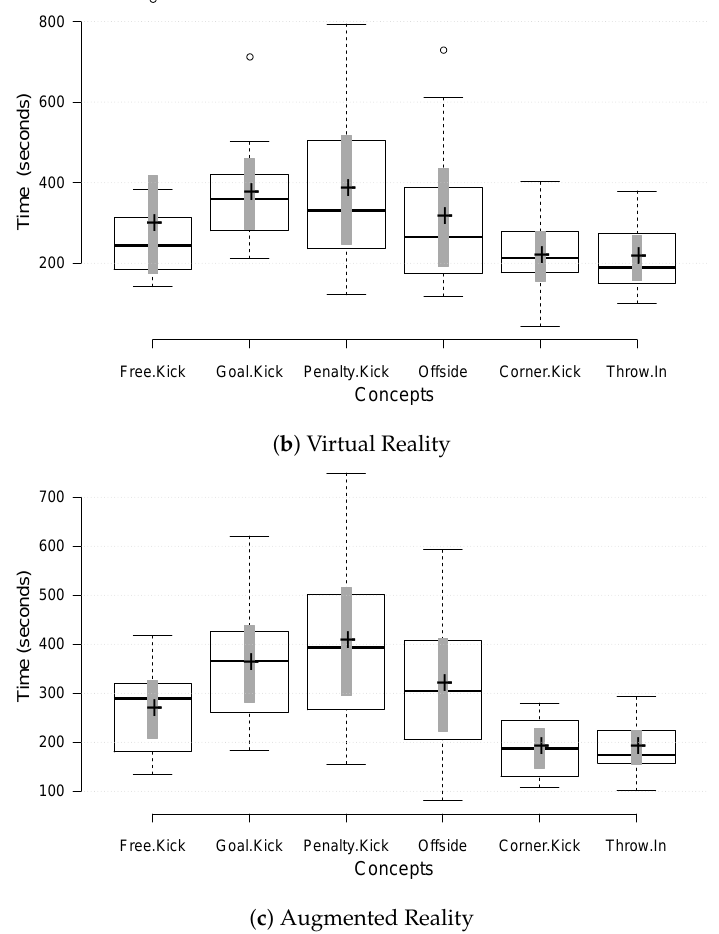
Figure 8. The three box plot charts show the mean concept deliberation time for each environment ( a ) desktop environment; ( b ) Virtual Reality environment and ( c ) Augmented Reality Environment.